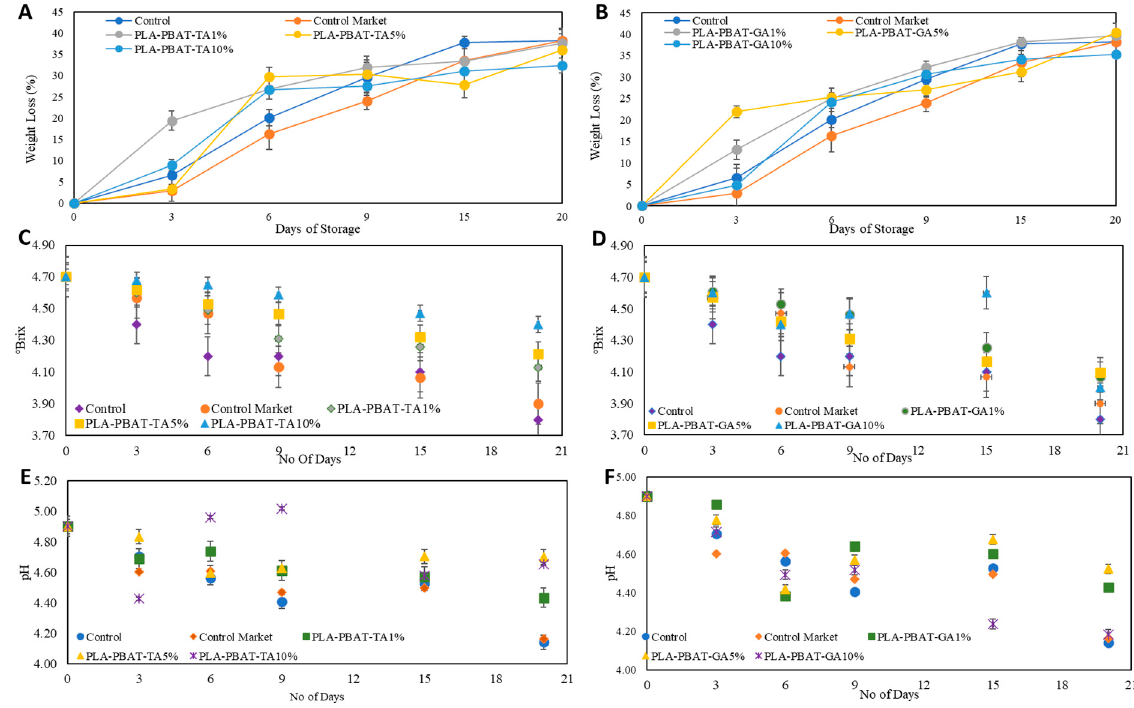
Figure 5. ( A ) Weight Loss of tomatoes during storage in TA composite film, ( B ) Weight Loss of tomatoes during storage in the GA composite film, ( C ) Total Soluble Solid (°Brix) of tomatoes in TA composite film, ( D ) Total Soluble Solid (°Brix) of tomatoes in GA composite film, ( E ) Change in pH of tomatoes in TA composite film, ( F ) Change in pH of tomatoes in GA composite film.